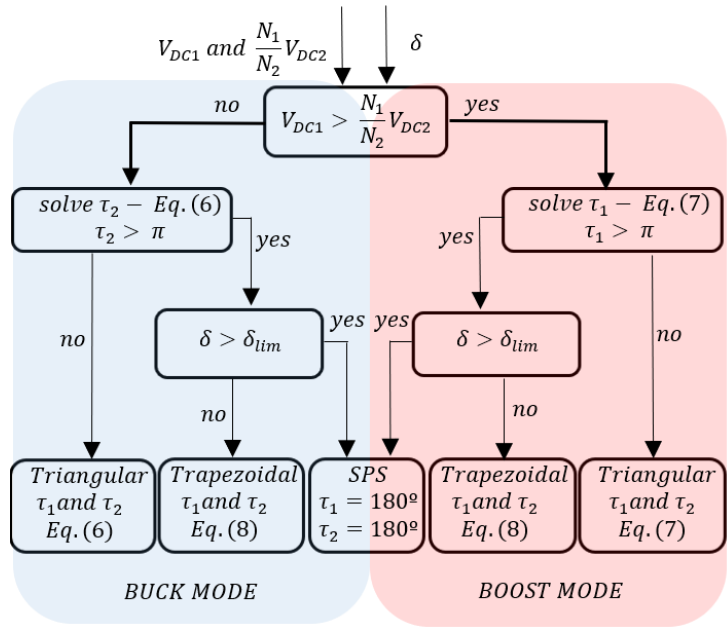
Figure 6. Modulation selection algorithm.